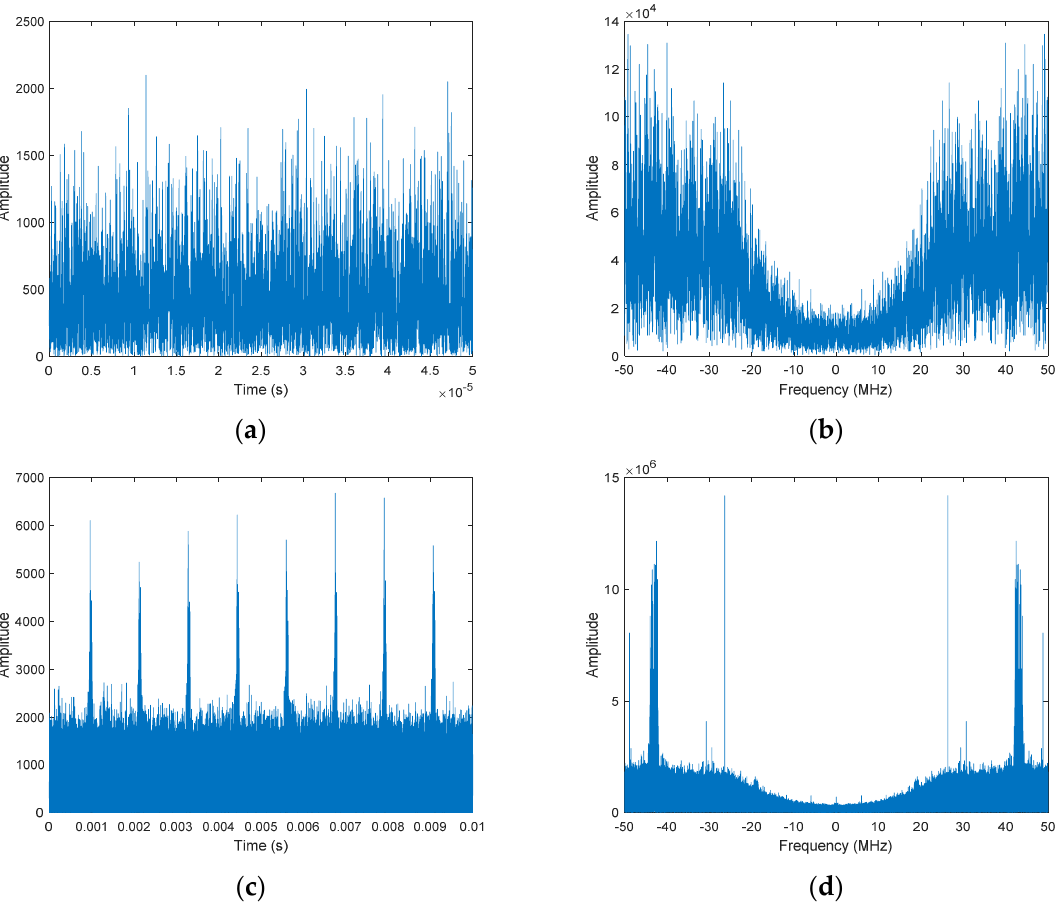
Figure A4. Beidou-2 IGSO navigation satellite signal analysis. ( a ) signal without RFI in time domain; ( b ) signal without RFI in frequency domain; ( c ) signal with RFI in time domain; ( d ) signal with RFI in frequency domain.